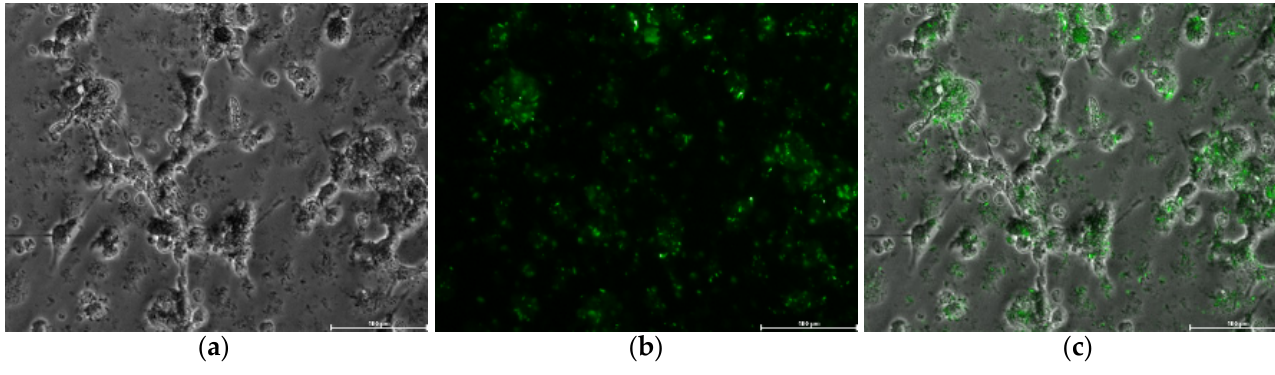
Figure 9. Human macrophage-like HL-60 cells after 24 h of the treatment with SFN-CUR at 0.1 mg · mL − 1 : ( a ) white field; ( b ) green channel; ( c ) merge. Scale bar = 100 μ m.